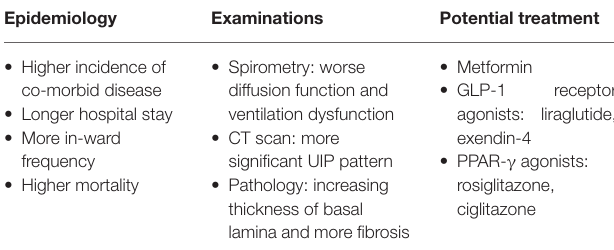
TABLE 1 | Characteristics in diabetic pulmonary fibrosis